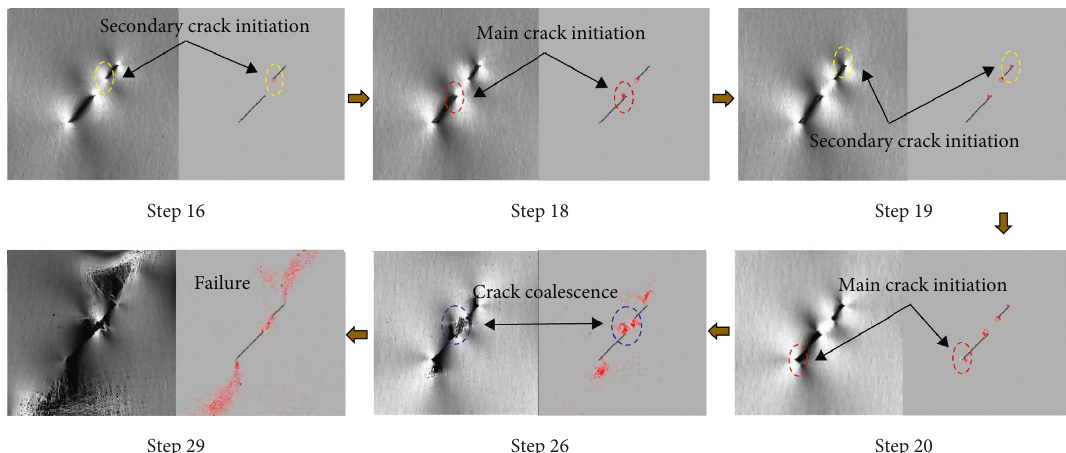
Figure 23: Crack initiation and propagation process in Model